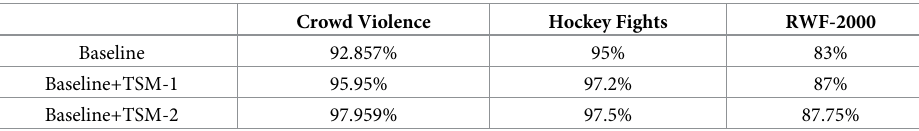
Table 3. Introduction of used datasets for violence